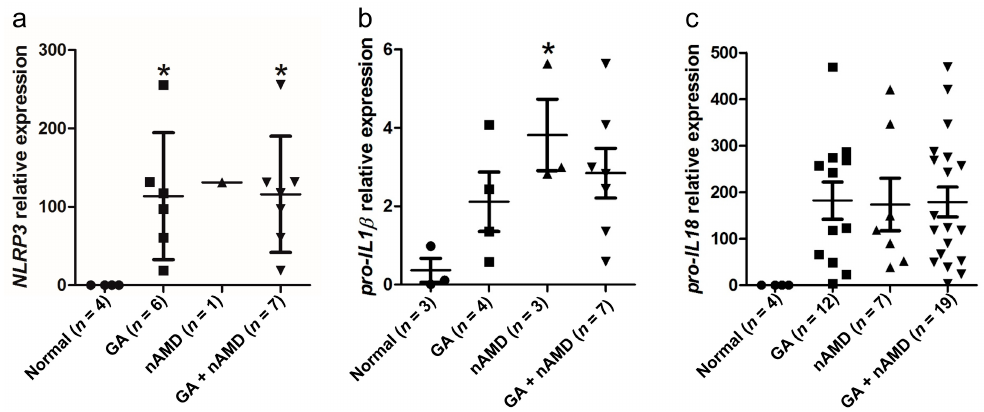
Figure 1. Upregulation of NLRP3 inflammasome in the maculae of geographic atrophy (GA) and neovascular age-related macular degeneration (nAMD) patients. ( a ) NLRP3 mRNA expression in the macular cells (mainly the photoreceptors and RPE cells) of paraffin-embedded slides of human eyes; ( b ) Pro- IL-1 β mRNA expression in the macular cells (mainly the photoreceptors and RPE cells) of paraffin-embedded slides of human eyes; ( c ) Pro- IL-18 mRNA expression in macular cells (mainly the photoreceptors and RPE cells) of paraffin-embedded slides of human eyes. Data are presented as mean ± SEM. * p < 0.05.